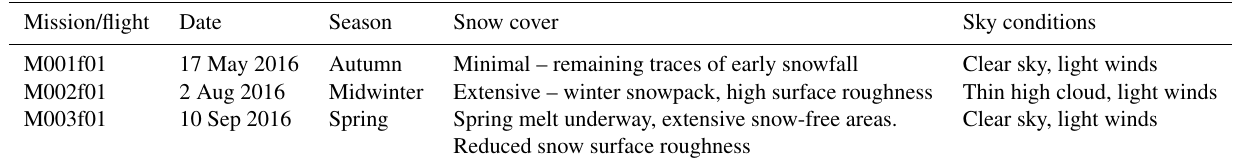
Table 1. Timing details for RPAS flights during 2016. All flights were completed between noon and early afternoon. Mission/flight Season Snow cover Sky conditions Autumn Minimal – remaining traces of early snowfall Clear sky, light winds Midwinter Extensive – winter snowpack, high surface roughness Thin high cloud, light winds 10 Sep 2016 Spring Spring melt underway, extensive snow-free areas. Clear sky, light winds Reduced snow surface